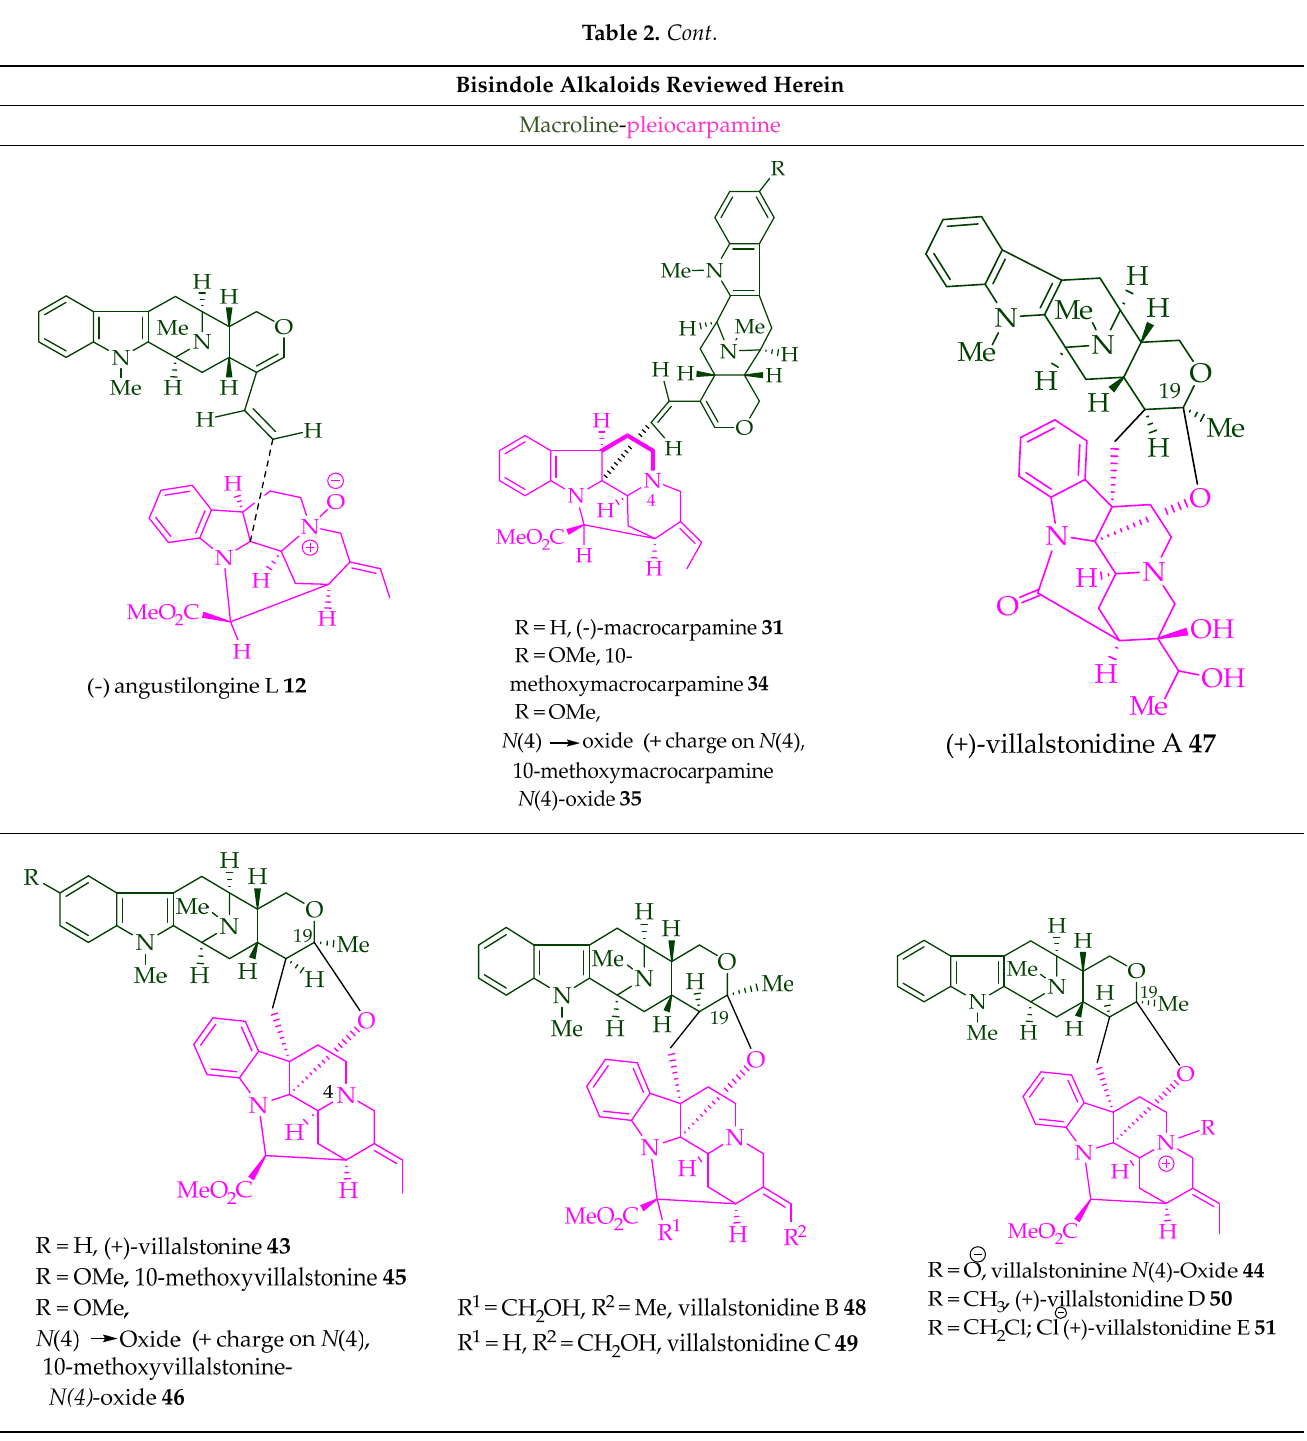
Table 3. Isolation and plant morphology of bisindole alkaloids from Alstonia species. Bisindoles Types of Monomeric Units Present in Bisindoles